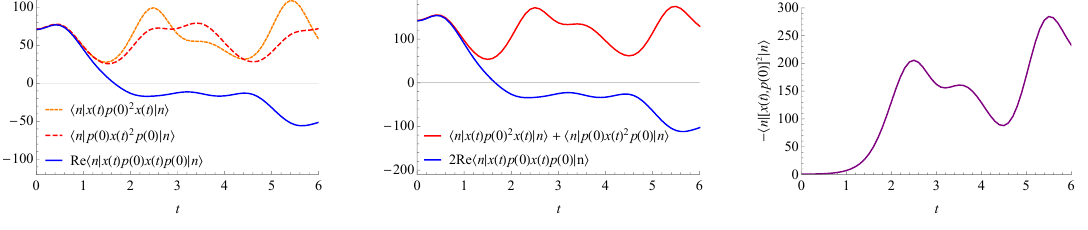
Figure 14 . Time evolution of the microcanonical OTOC at n = 11